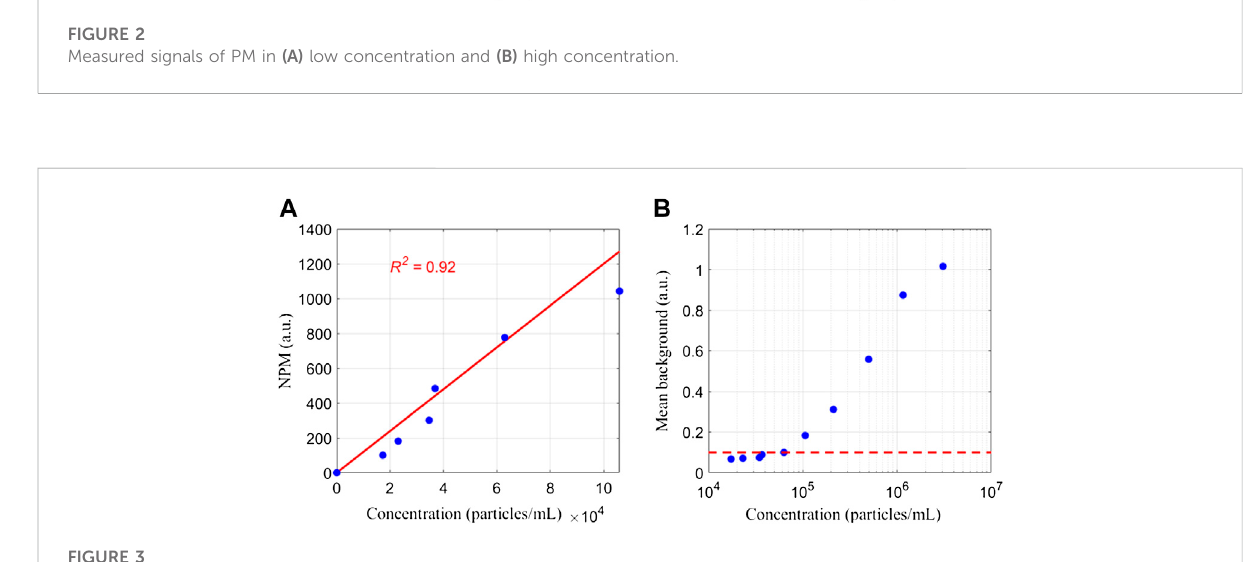
FIGURE 3 (A) NPM and (B) mean background with different